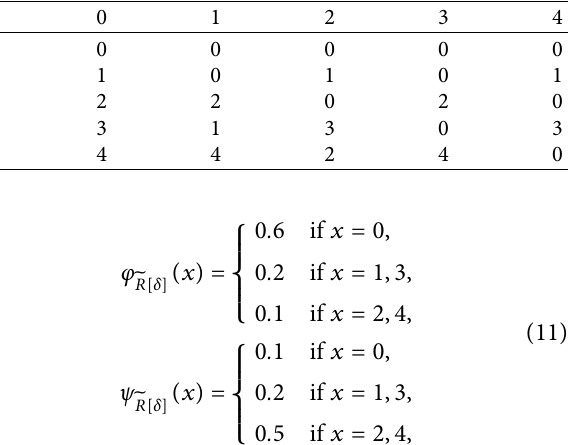
Table 2: : Cayley table of the binary operation ∗